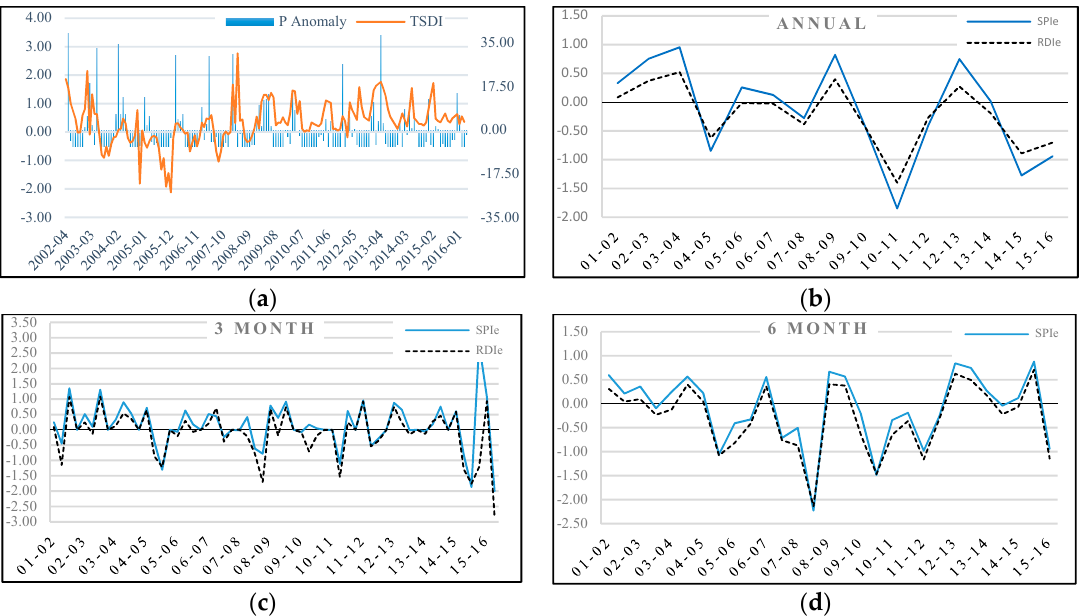
Figure 11. Drought detecting and monitoring in the hyper-arid zone of the studied area by ( a ) TSDI; ( b ) Annual SPI and RDIe; ( c ) SPI-3 and RDIe; ( d ) SPI-6 and RDIe-6.